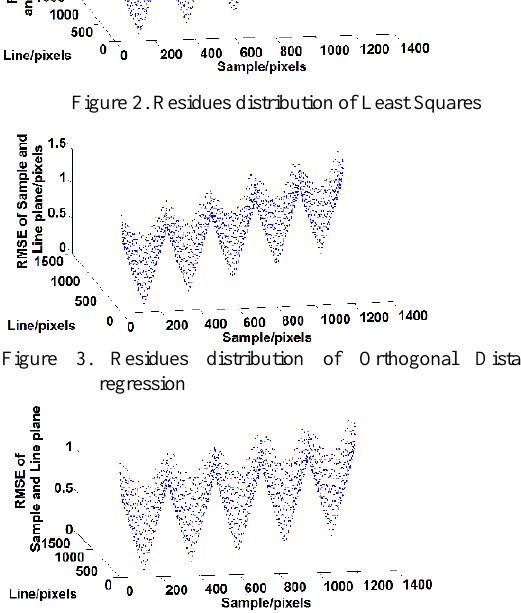
Figure 4. Residues distribution of Stepwise and Orthogonal Distance regression